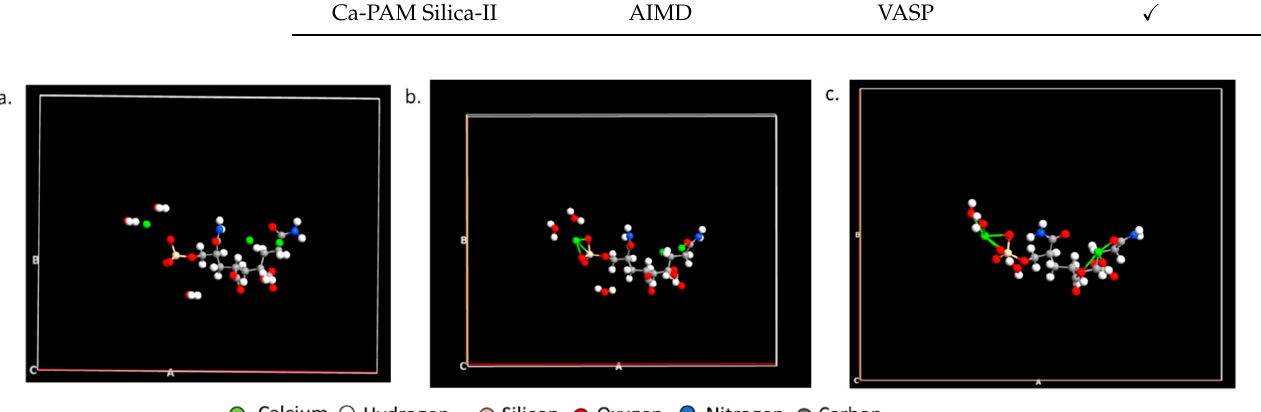
Figure 8. The radial distribution function of the MD trajectory of PAM ‐ Silica with Ca 2+ ions.